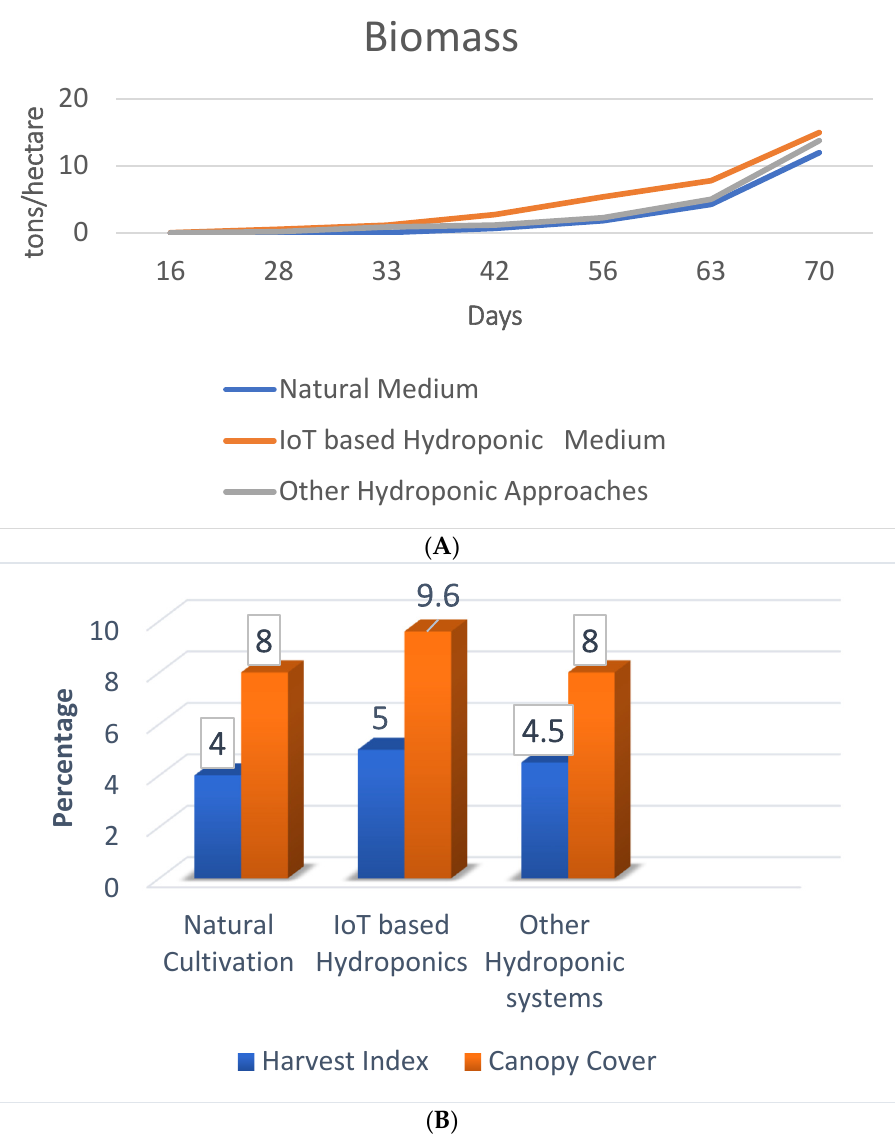
3kg/m3 higher than other models and naturally cultivated saffron, as shown in Figure 13 A,B. The yield obtained in the designed framework is 7.8 kg/hectare, which is higher than all other existing models.